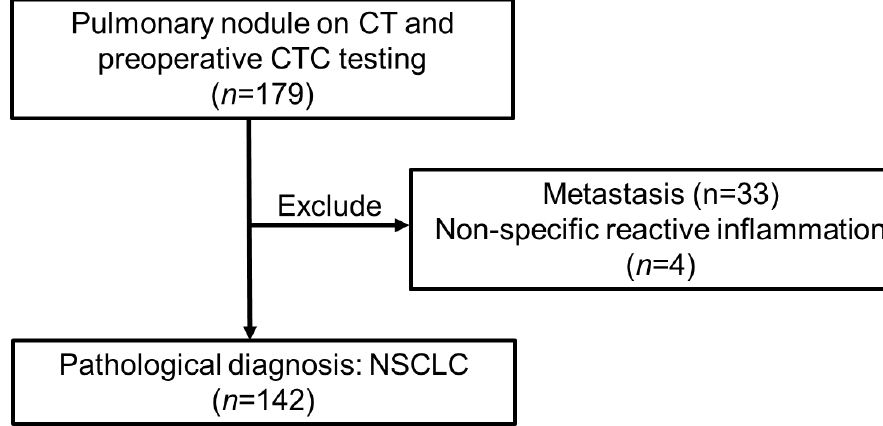
Figure 2. Patient selection flow chart. CT, computed tomography; CTC, circulating tumor cells; NSCLC, non-small cell lung cancer.